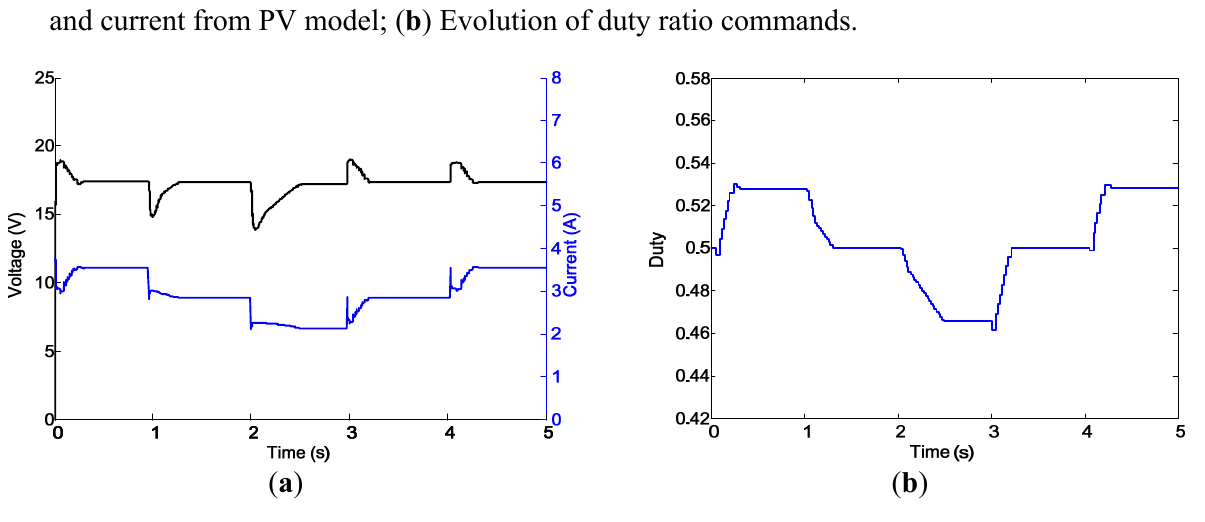
Figure 18b are the trajectories of power versus PV voltage during the irradiation variation simulation.